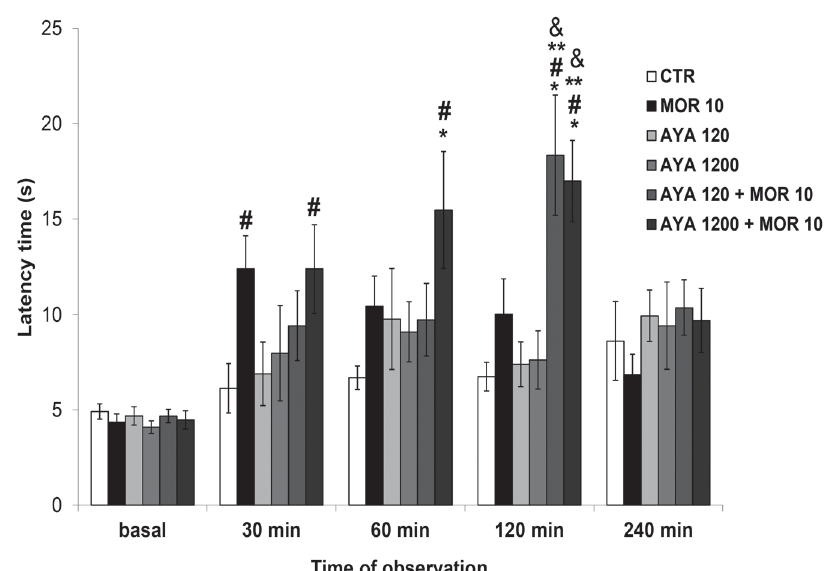
FIGURE 3 - Effect of ayahuasca (AYA, 120 and 1200 mg/kg, p.o.) associated with morphine (MOR, 10 mg/kg, i.p.) on the latency time of mice responding to the thermal stimulus. Results are expressed as the mean ± SEM (n=7-10). (*) p <0.05: statistically different from control; (#) p <0.05: statistically different from corresponding basal; (**) p <0.05: statistically different from morphine; (&) p <0.05: statistically different from corresponding dose of ayahuasca at the same observation time. 2-way ANOVA followed by Newman Keuls test.